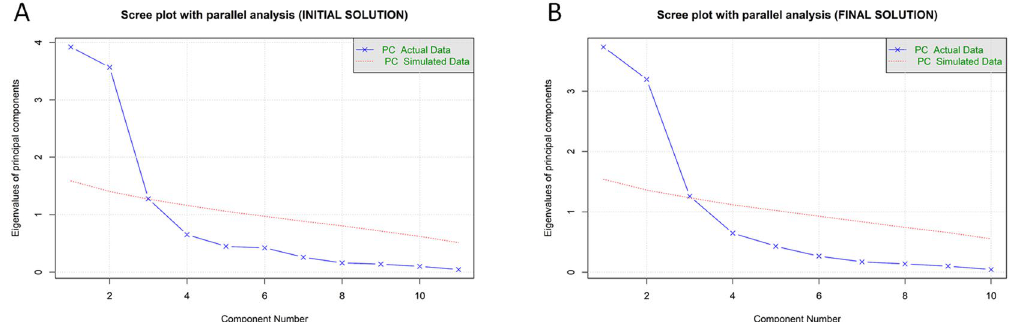
Figure 4. Scree plots with parallel analyses. ( A ) Scree plot (the line with × s) showing eigenvalues of the initial principal component analysis (PCA) and parallel analysis with 100 simulations (dashed line). ( B ) Scree plot (the line with × s) showing eigenvalues of the final PCA and parallel analysis with 100 simulations (dashed line). The figures are created in RStudio (Version 1.4.1106) 80 using the function fa.parallel of the package psych (version 2.1.3) 72 . PC principal